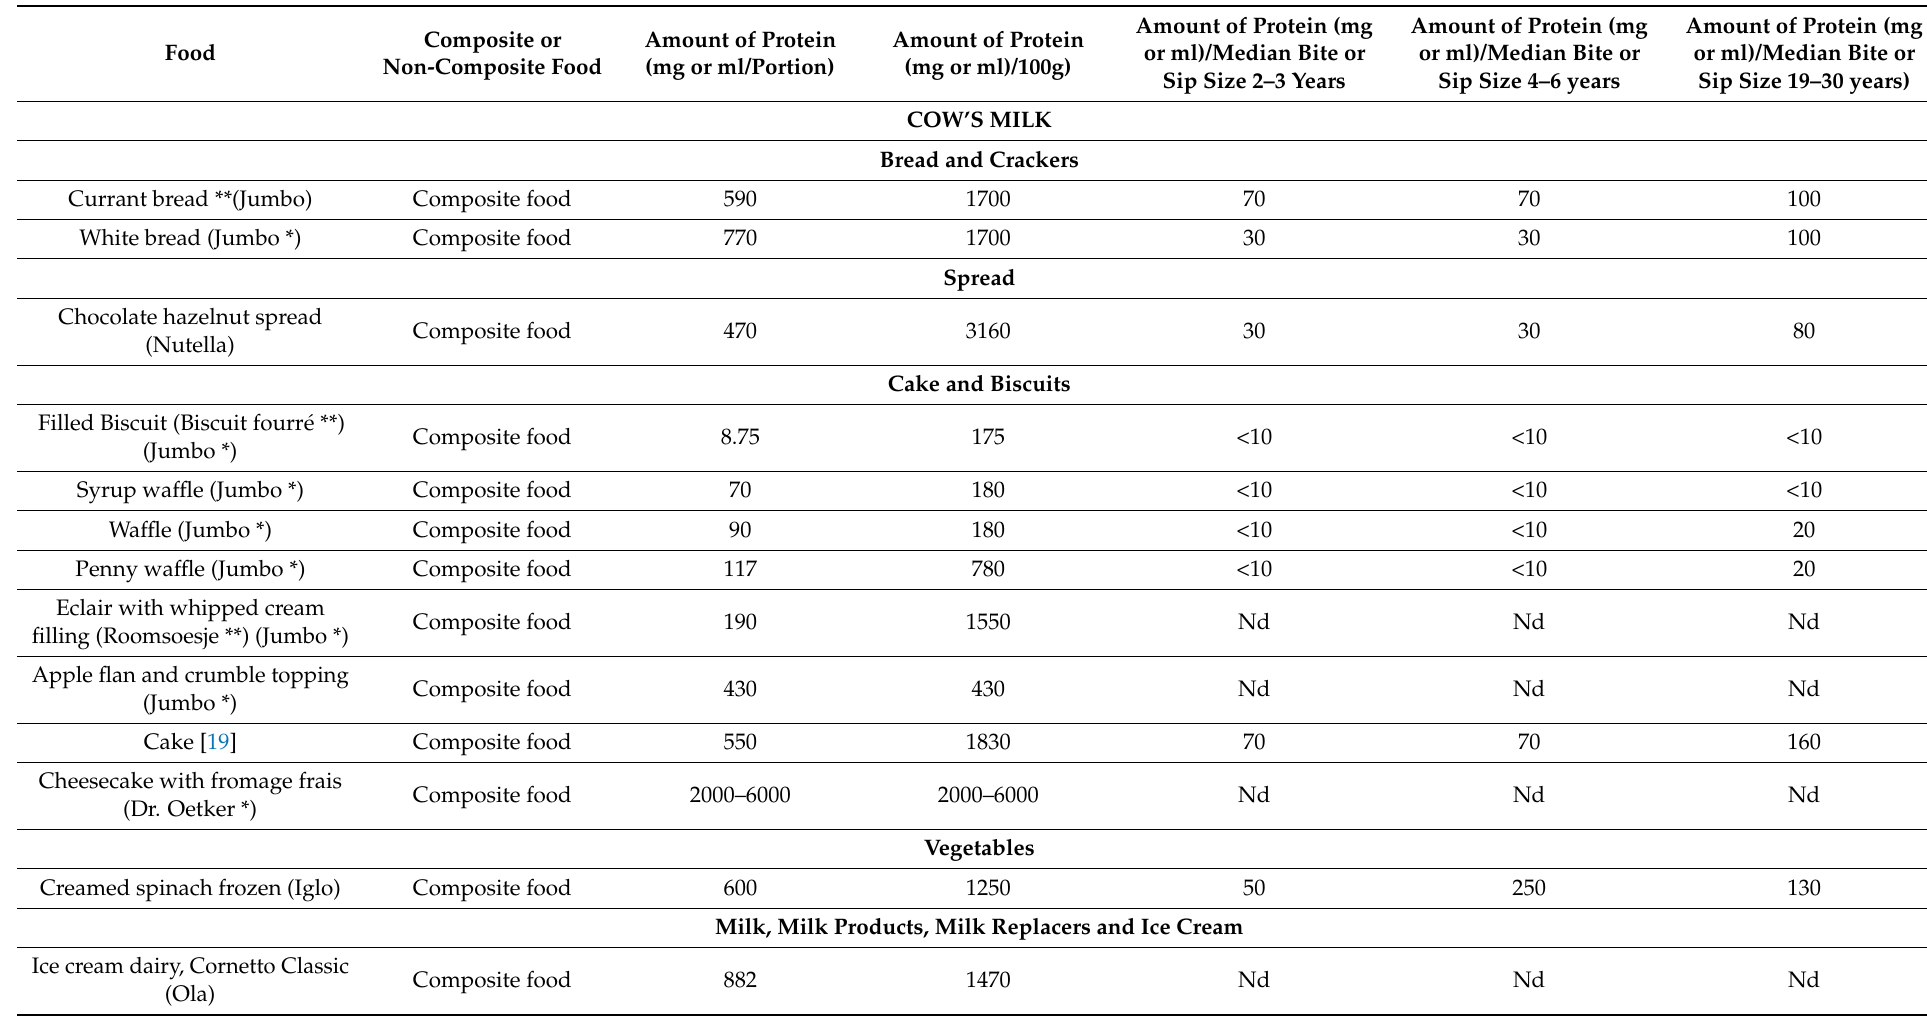
Table 2. Amount of estimated allergenic protein in most frequently consumed composite foods in mg or ml per portion, mg or ml per 100 g and mg or ml per median bite or sip size in different age